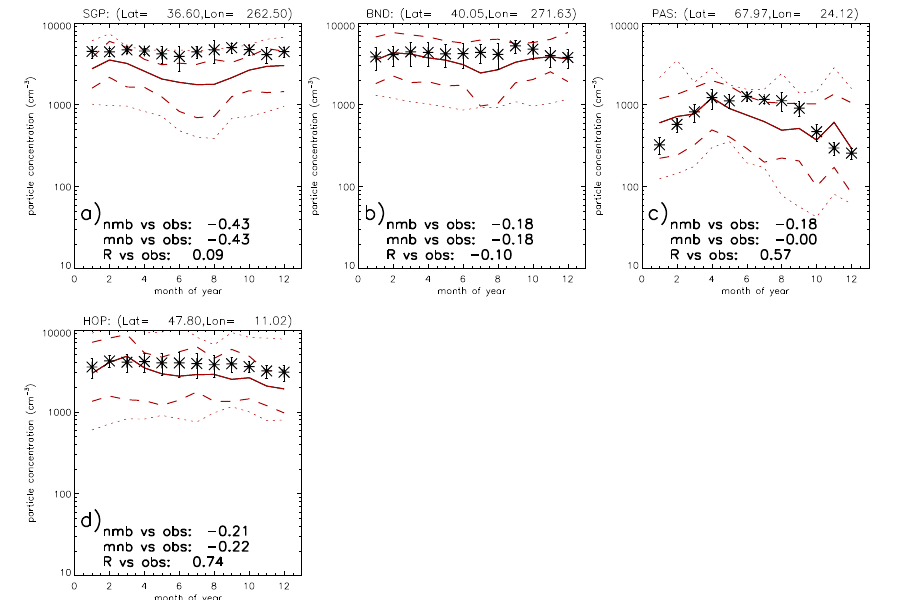
Figure 9. Simulated annual cycle in surface N(D p > 10nm/14nm/3nm) against CPC observations at continental boundary layer GAW sites Southern Great Plains (10nm), Bondville (14nm), Pallas (10nm) and Hohenpeissenberg (3nm). The solid line is the geometric mean over the central two-thirds models in each month, with the dashed lines the minimum and maximum over those central-8. The dotted line shows the minimum and maximum over all 12 models. The error bars on the observations indicate the standard deviation over the several years of data shown in Table 3.